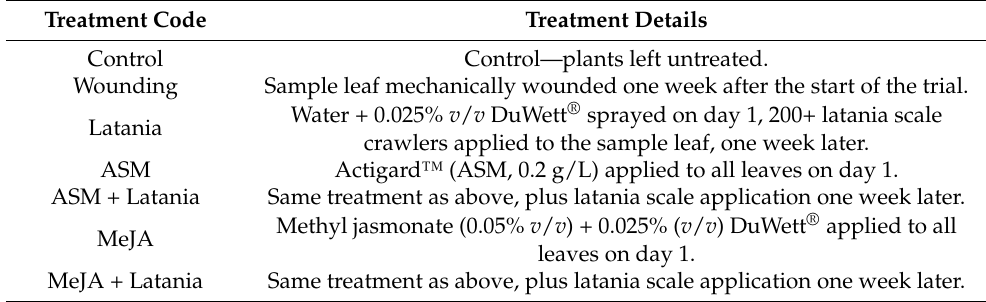
Table 1. Treatments applied to ‘Hort16A’ and ‘Hayward’ kiwifruit plants. Treatment Code Treatment Details